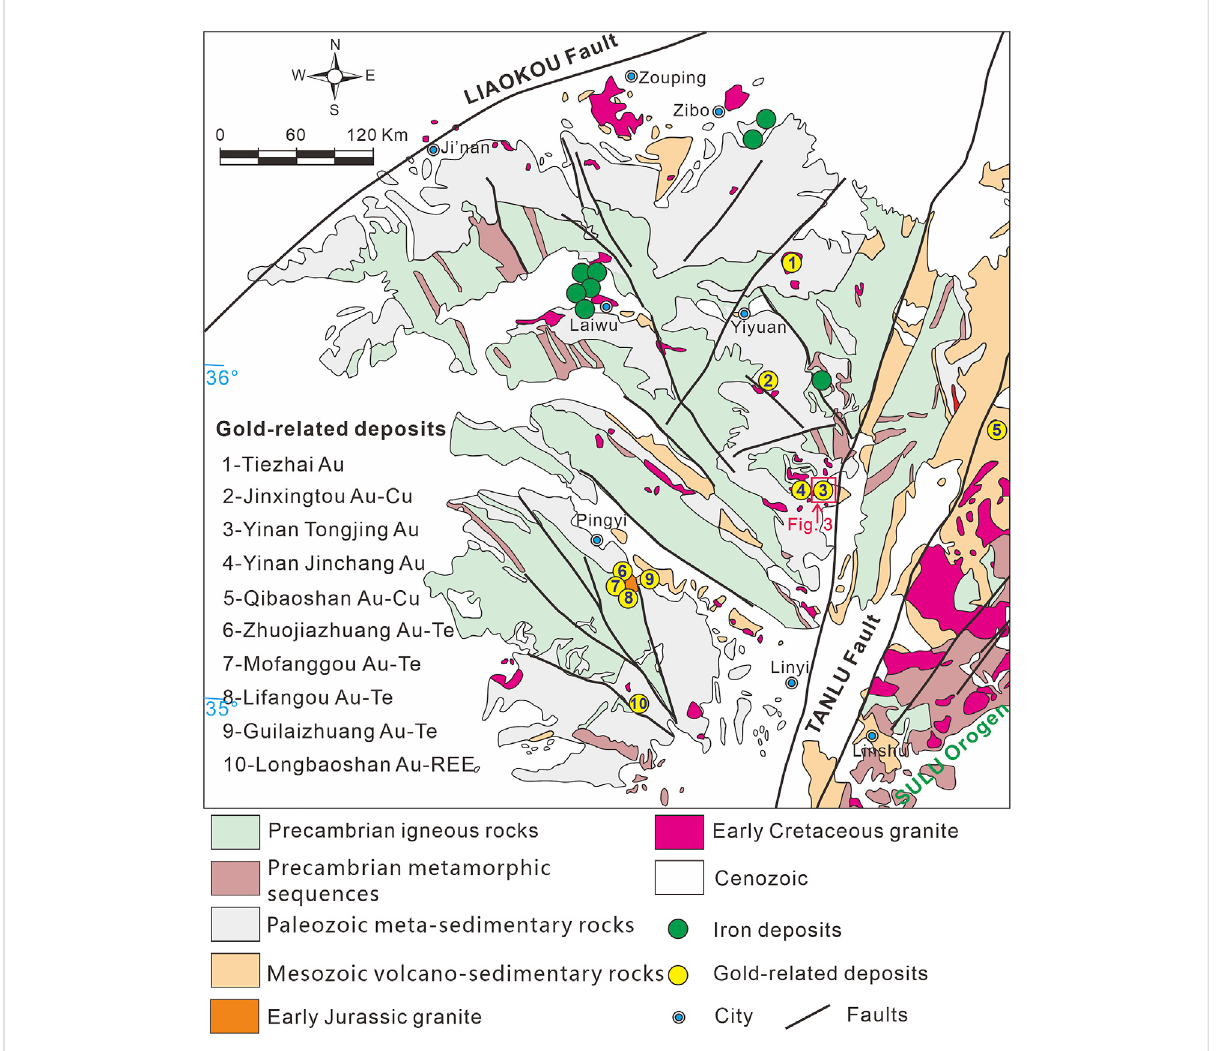
FIGURE 2 Simpli fi ed geological map of the Luxi district with major deposits marked (modi fi ed after Deng et al., 2018).